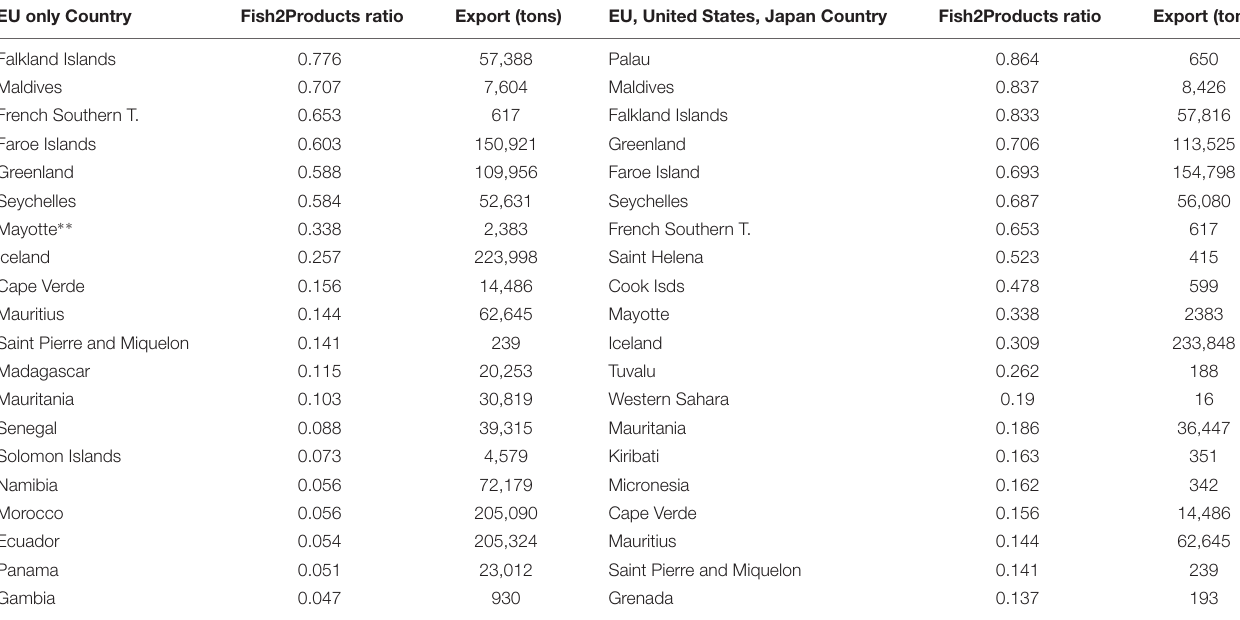
TABLE 4 | Top Fish2Products ratio ∗ of fish exporting countries to the EU only and to the EU, the United States and Japan combined. EU only